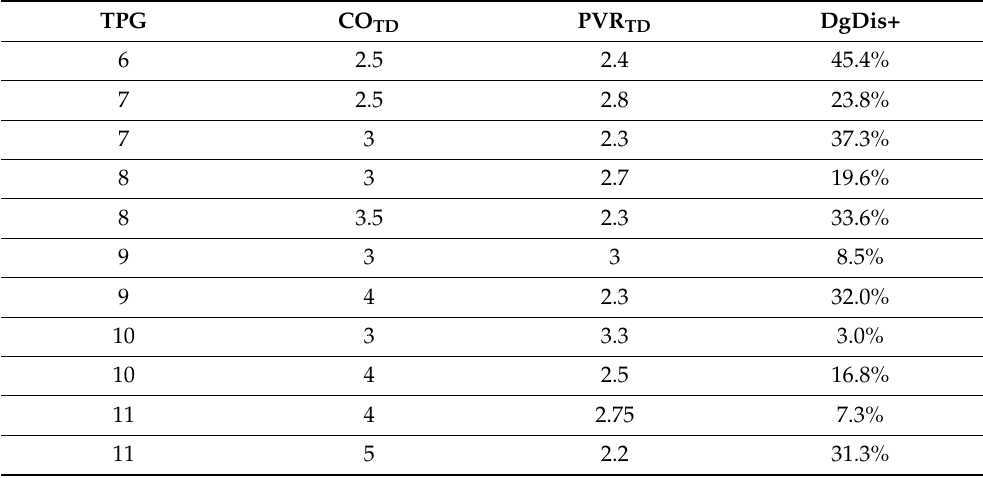
Table 3. Examples of patients diagnosed with PcPH using TD and corresponding DgDis+